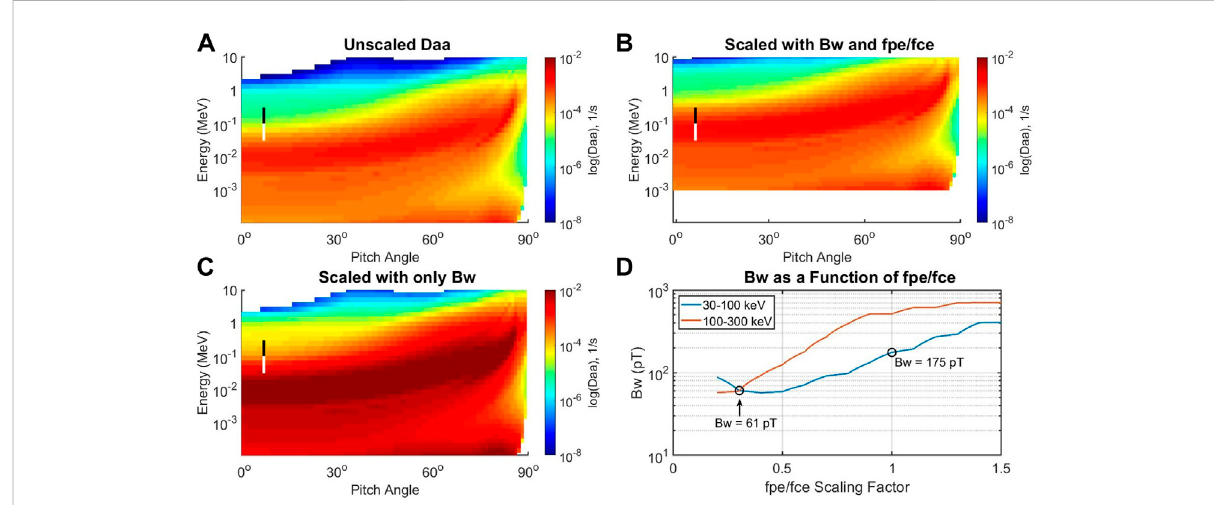
FIGURE 4 Scaling diffusion coef fi cients for f pe / f ce and B w . In plot (A) is the PADIE statistical diffusion coef fi cient D αα to be scaled. The Li et al. (2013)and Ni et al. (2014) method in Section 4.1 for scaling with B w is done by integrating at the loss cone from 30 to 100 keV and 100 – 300 keV. This integration pathisshownasthethickwhiteandblackverticallinesat α ≈ 7 ° inplots (A – C) .Plot (D) showstheinferredvalueof B w asafunctionofscaling f pe / f ce by a constant. The Li et al. (2013) method does not scale f pe / f ce , so it infers B w (cid:2) 175 pT , which creates the very strong diffusion coef fi cient in plot (C) . In contrast, the new method developed in this paper fi nds the intersection of the curves for the 30 – 100 keV band and the 100 – 300 keV band in plot (D) . This method infers B w (cid:2) 61 pT , while also scaling the diffusion coef fi cient up in energy using Eq. 25, with f pe / f ce reduced by a factor of 1/3. This method produces a much weaker overall diffusion coef fi cient since the shift in energy puts the stronger part of the diffusion coef fi cient in the integration path (vertical white and black line at α ≈ 7 ° ) when calculating J 0 / J 90